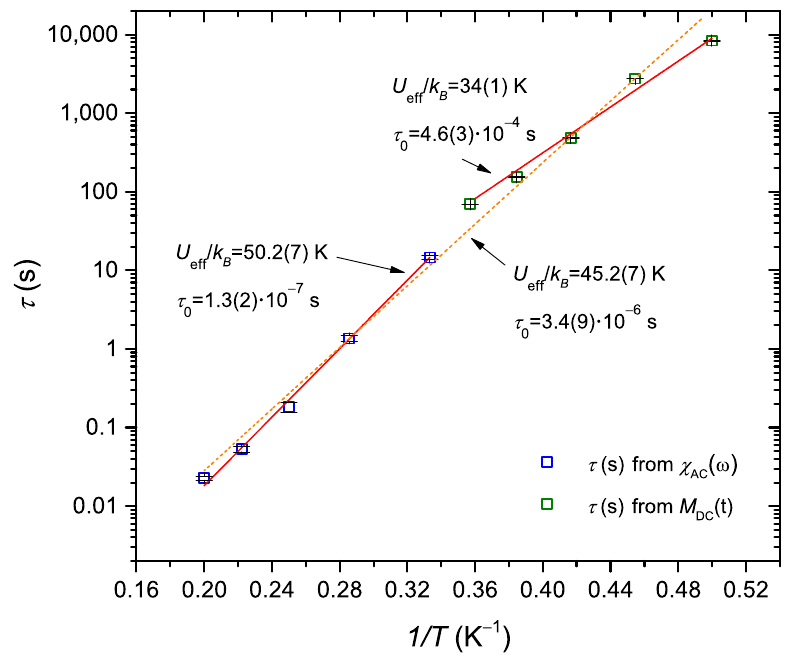
Figure 5. Relaxation times in function of the inverse temperature for sample SilS-Mn 12 , derived from the AC susceptibility measurements and DC magnetization measurements (solid lines stand for the best fit to the Arrhenius function (2) for each measurement and the dashed line represents the best fit to such a function for both the DC and AC relaxation